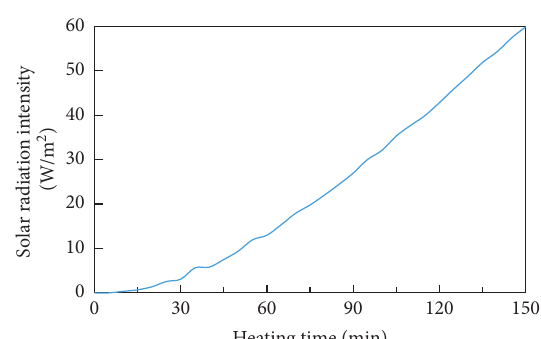
Figure 3: Solar radiation intensity